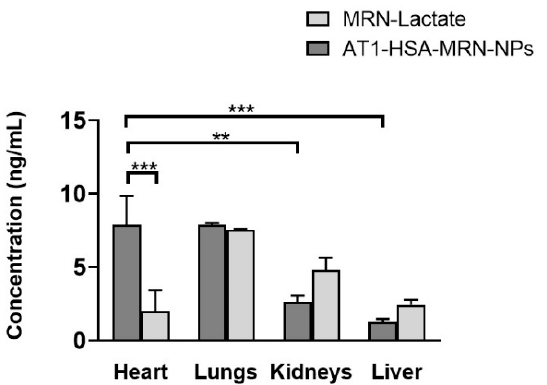
Figure 6. Tissue distribution of AT1-HSA-MRN-NPs and MRN-Lactate at an initial MRN dose of 50 µ g/kg in vivo. The graph shows a representative result of mean ± SD ( n = 4). *** p < 0.001 was considered highly significant and ** p < 0.01 was considered significant based on Tukey’s post hoc anal- ysis.